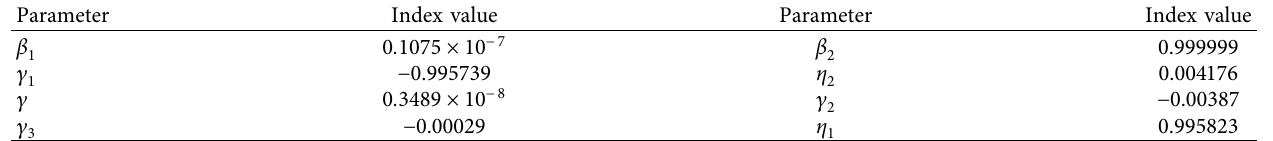
Table 1: The results represent the sensitivity indices of epidemic